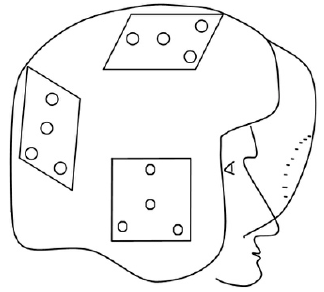
Figure 14. A helmet with multiple groups of four non-coplanar feature points .